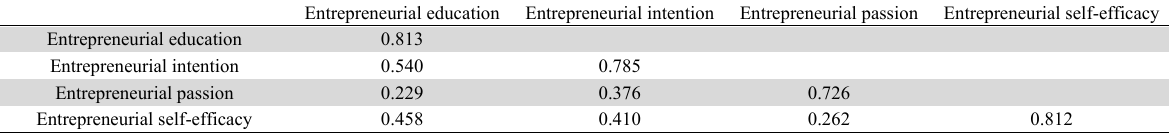
Discriminant Validity (Fornell-Larcker